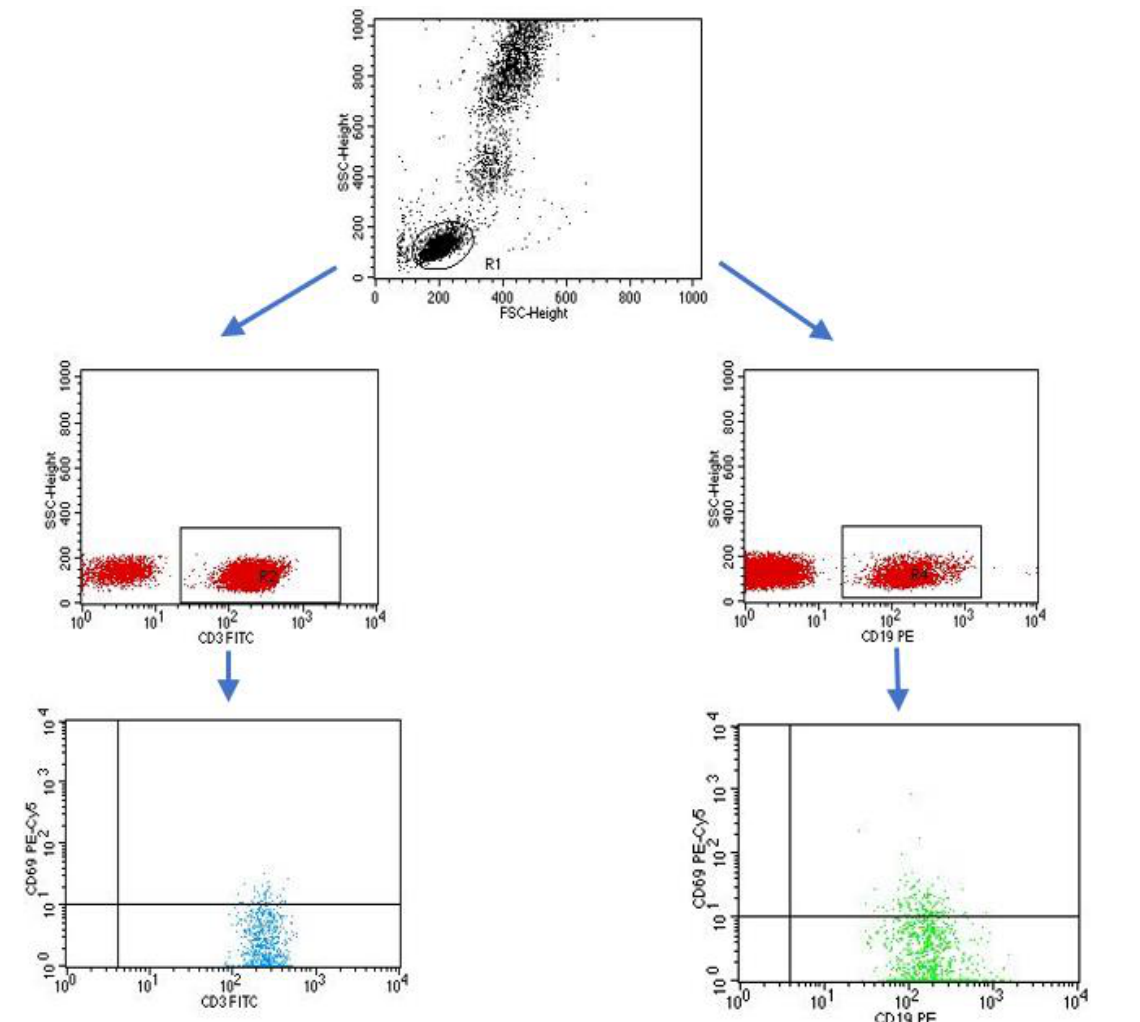
Figure 8. Sample analysis of the percentage of lymphocytes with the CD3+CD69+ and CD19+CD69+ phenotype.